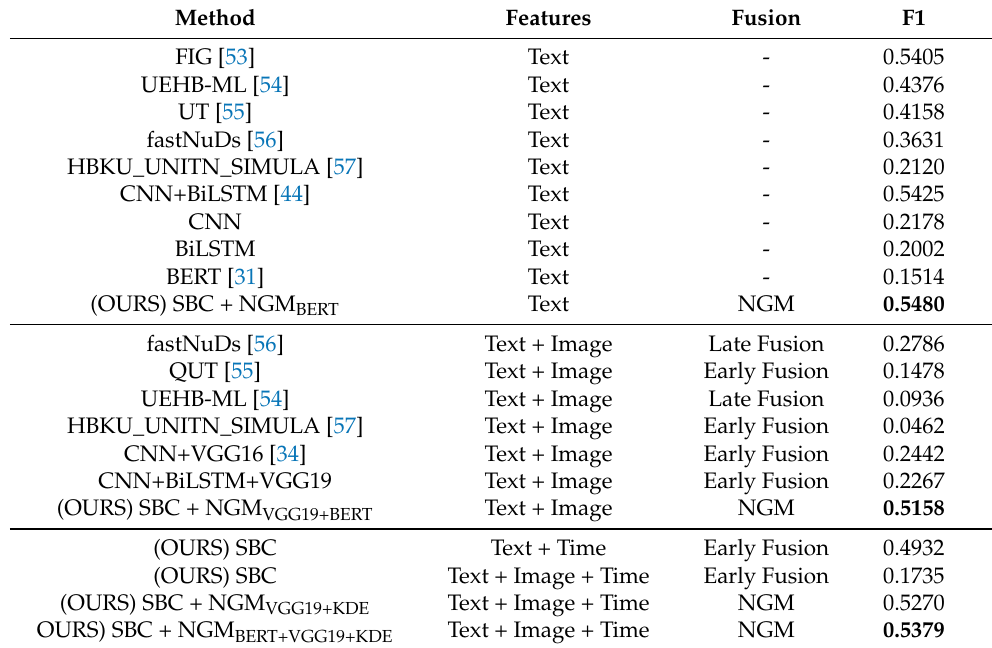
Table 5. Experimental